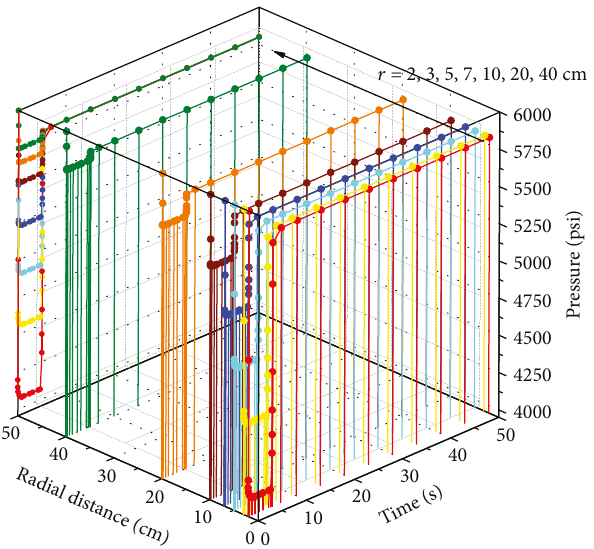
Figure 4: Pressure distribution versus time and radial